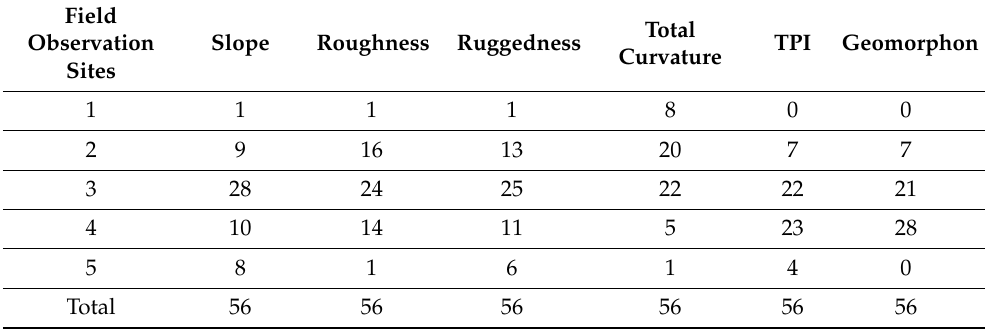
Table 5. Comparison of results of geodiversity assessment based on different geomorphological models with location recognized through field observation.